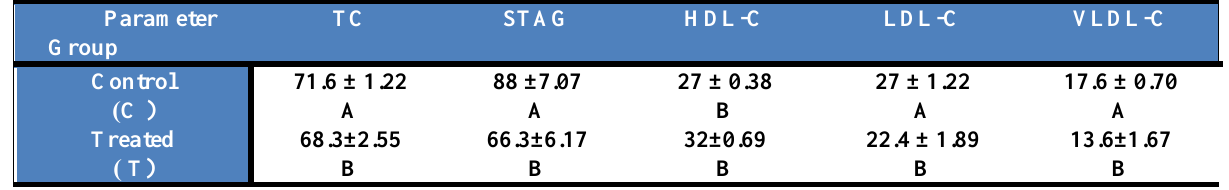
Table, 3: Effect of ethanolic extract from Metracaria chamomella on Serum lipid profile concentration (mg/dl) in male rabbits.